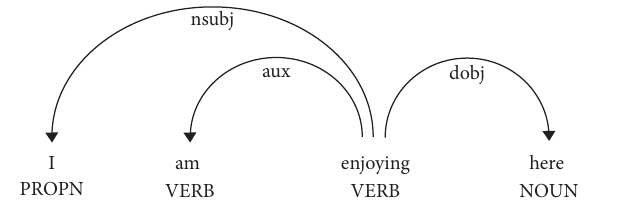
Figure 3: The subject of the sentence “I” referring to the first-person singular, which most likely implies that the customer belongs to the category